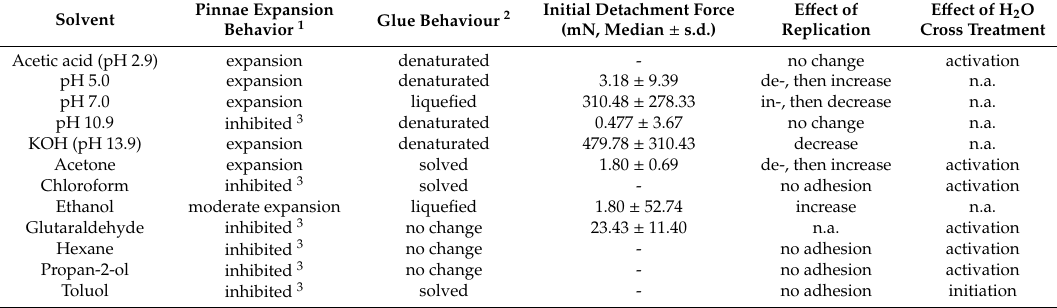
1 Figure 3B–D. 2 Figure 5. 3 reversible with water